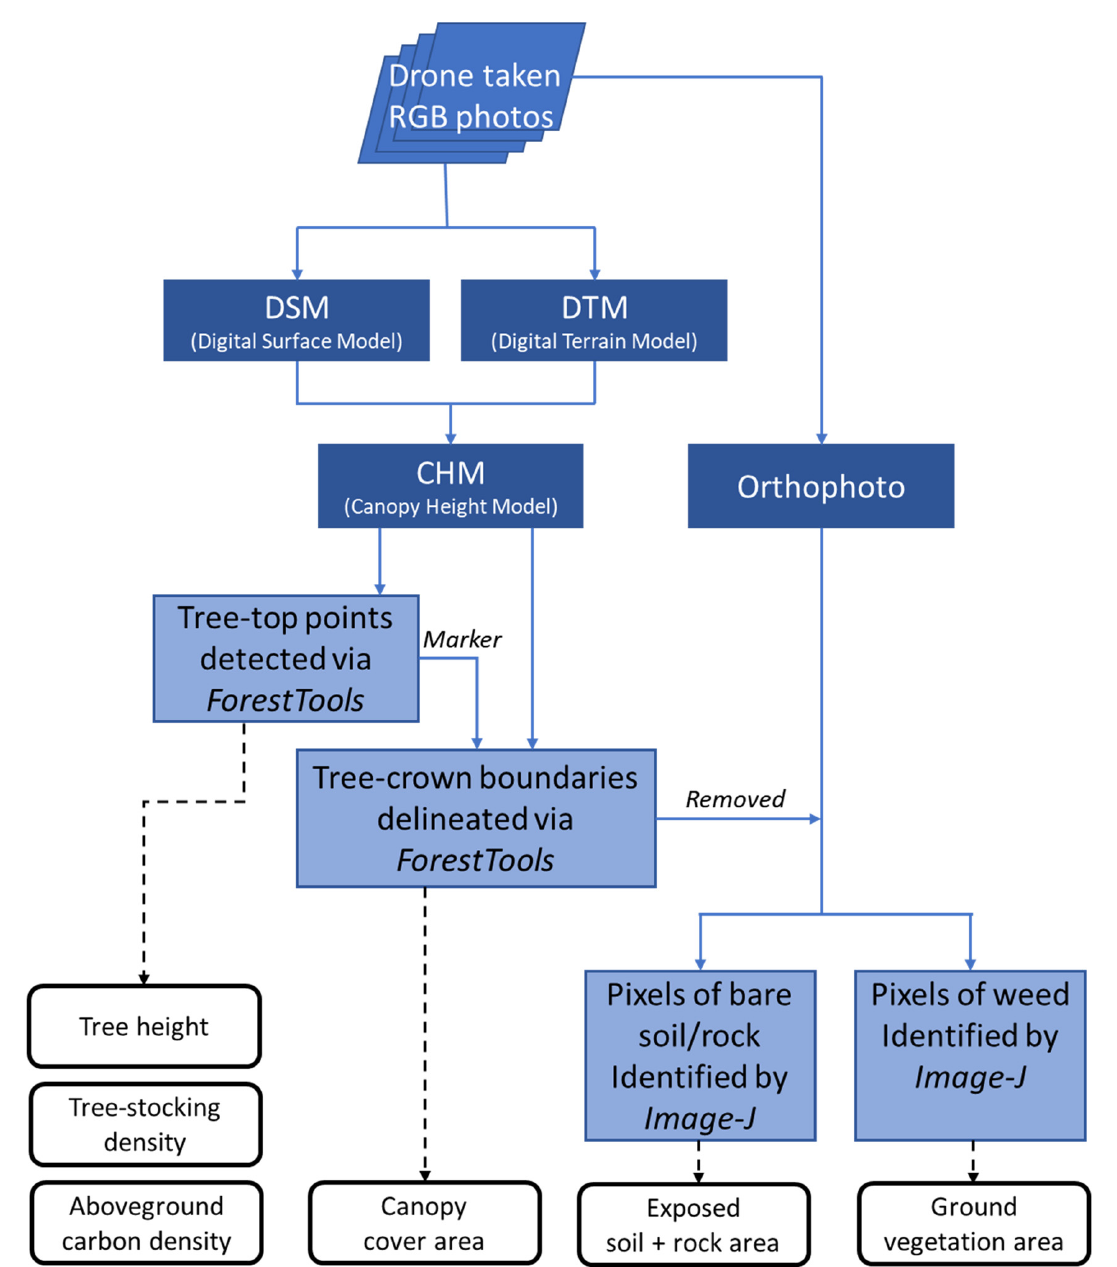
Figure 3. Flowchart of processing the drone RGB imagery to quantify indicator variables.